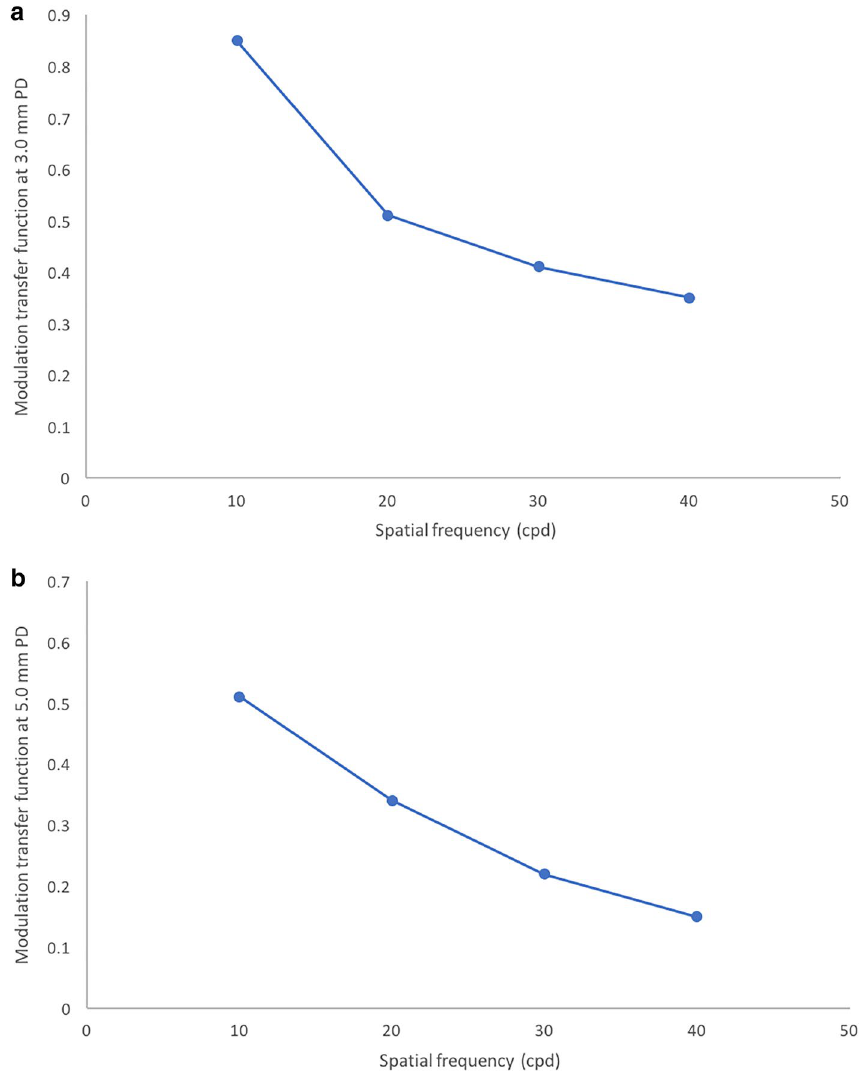
Figure 5. ( a ) Modulation transfer function curve with a 3.0 mm pupil diameter at different spatial frequencies at 12 months post-operative (cpd—cycles per degree). ( b ) Modulation transfer function curve with a 5.0 mm pupil diameter at different spatial frequencies at 12 months post-operative (cpd—cycles per degree).